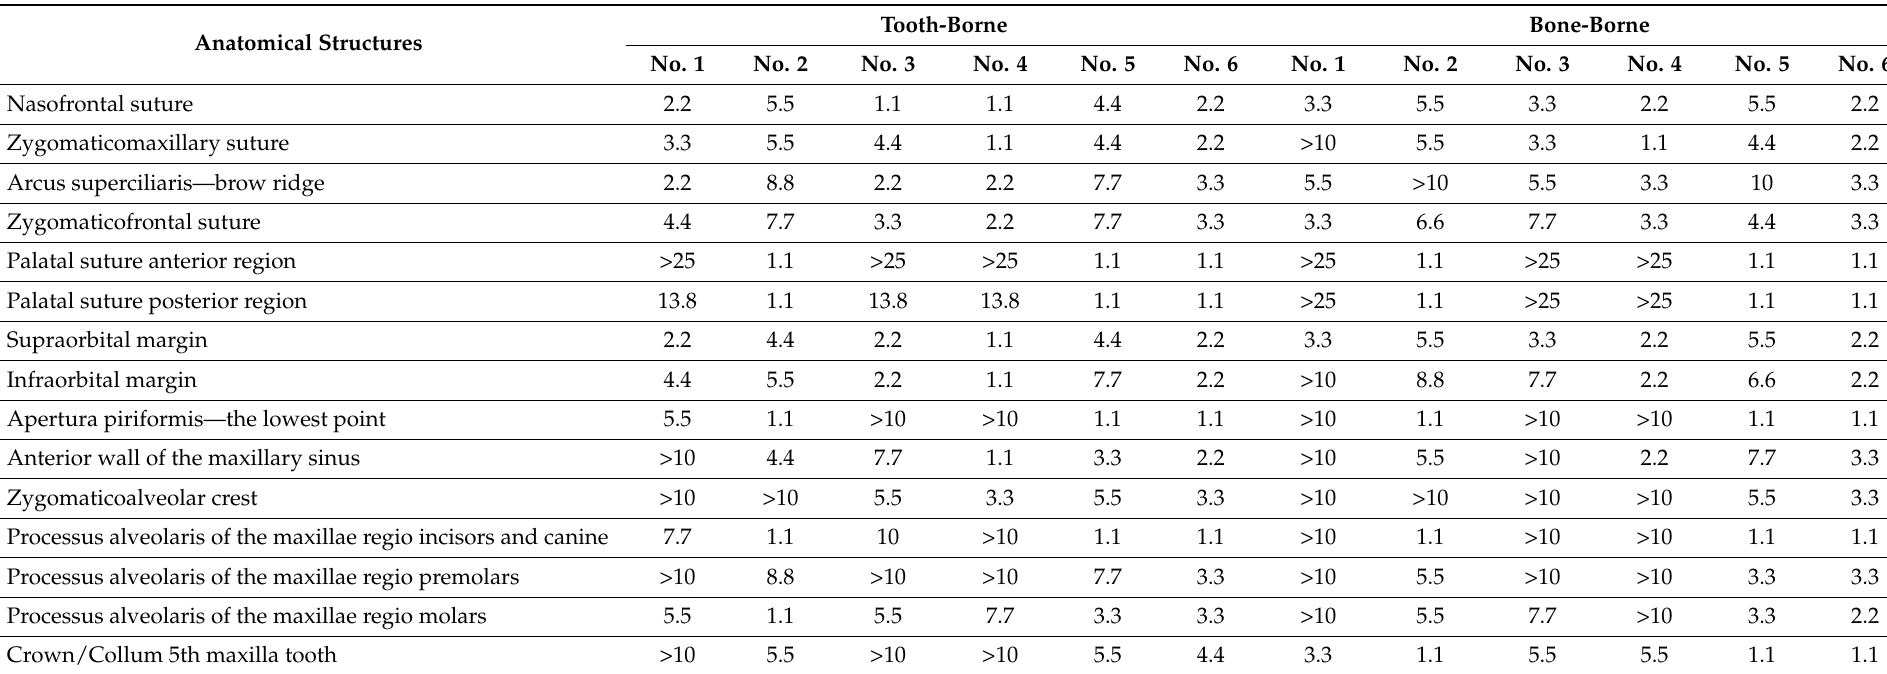
Table 3. Stress distribution (MPa) according to Huber throughout the craniofacial model with various surgical procedures and the tooth-borne and bone-borne orthodontic appliance using the finite element